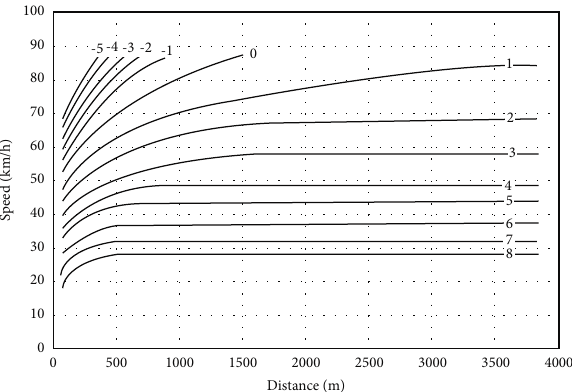
Figure 1: Increased acceleration in the slope [27].